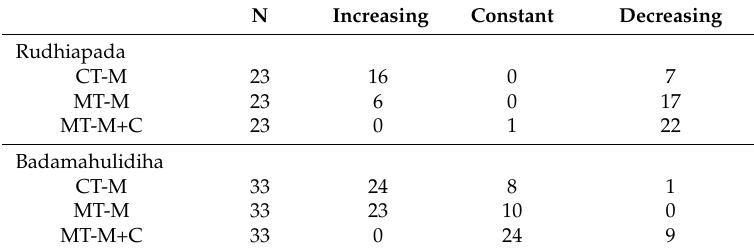
Table 5. Distribution of smallholder farmers according to types of returns to scale among different conservation agriculture cropping systems in two villages in Odisha, India. N Increasing Constant Decreasing Rudhiapada CT-M